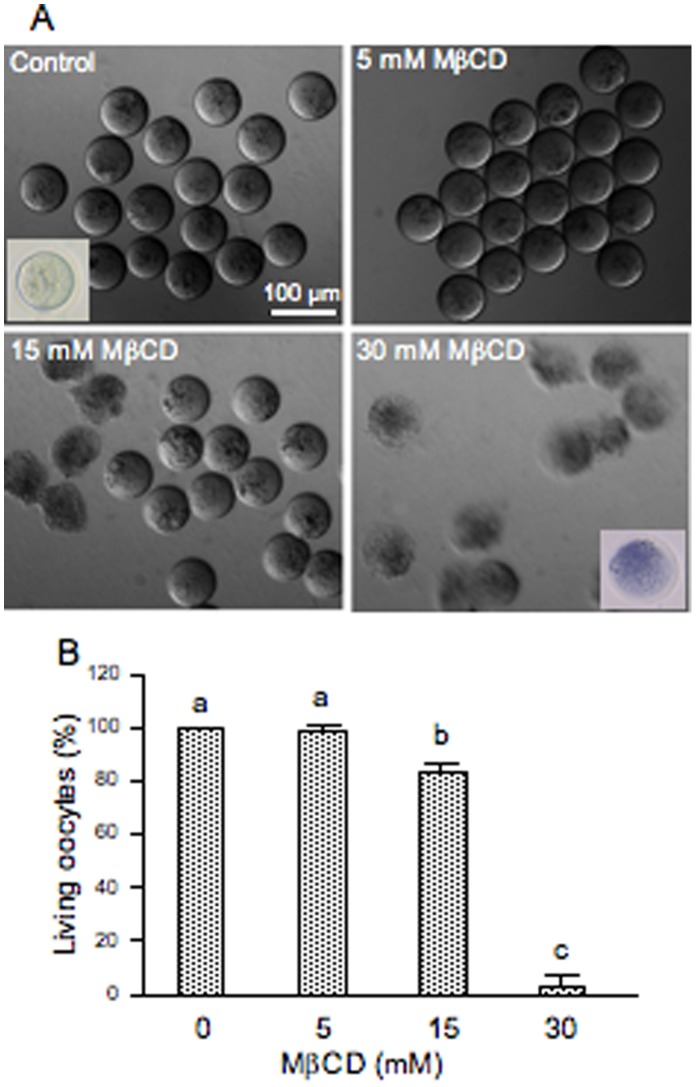
Effect of cholesterol depletion mediated by MβCD on oocyte survival.Zona-free mouse oocytes were incubated with different concentrations of MβCD for 30 min at 37°C. (A) Differential interference contrast micrographs of depleted oocytes after MβCD treatment. Are also illustrated by inserted pictures healthy and dead oocytes demonstrating or not their viability by the trypan blue exclusion test. (B) Percentages of living oocytes after cholesterol depletion. Data represent the mean ± SEM of at least 3 independent experiments from a total of 101 control oocytes, 49 oocytes depleted at 5 mM, 92 oocytes depleted at 15 mM and 29 oocytes depleted at 30 mM of MβCD. Comparison of mean values was performed using Bonferroni test. Different letters (a-c) denote significant differences (P<0.05).